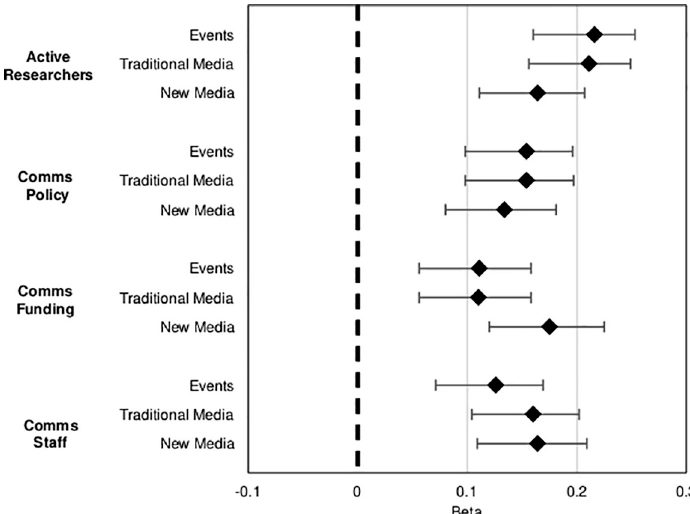
Fig 4. Forest plot explaining variation for level of public communication (dependent variables ‘public events’, ‘traditional news media’ and ‘new media’) regressed on context C and D variables; D variables are represented. Diamonds represent the standardised betas and the whiskers the 95% CIs (confidence intervals) (see S7–S9 Tables for representation of all variables in the models).